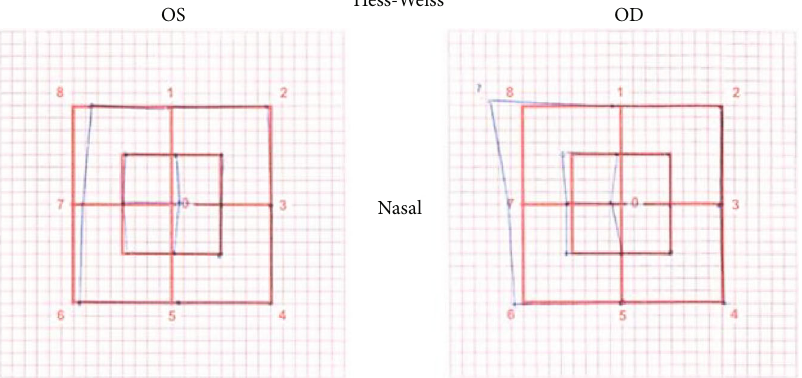
Figure 1: The Hess-Weiss test at presentation. Abbreviations: OS, oculus sinister, left eye; OD, oculus dexter, right eye.